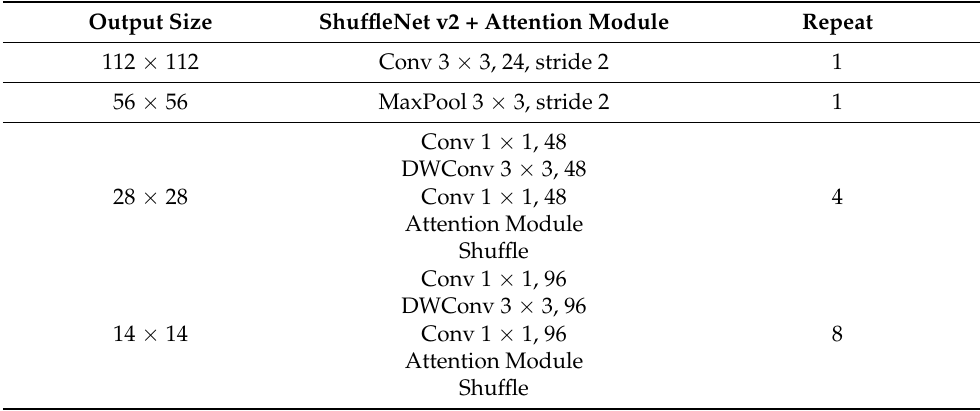
Table 2. Engagement-recognition model